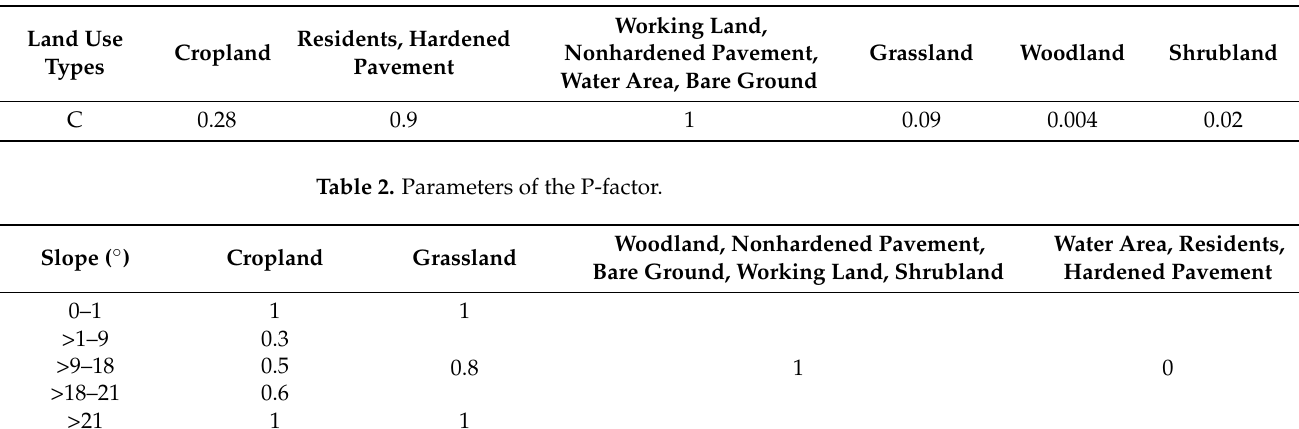
Table 1. Parameters of the C-factor.